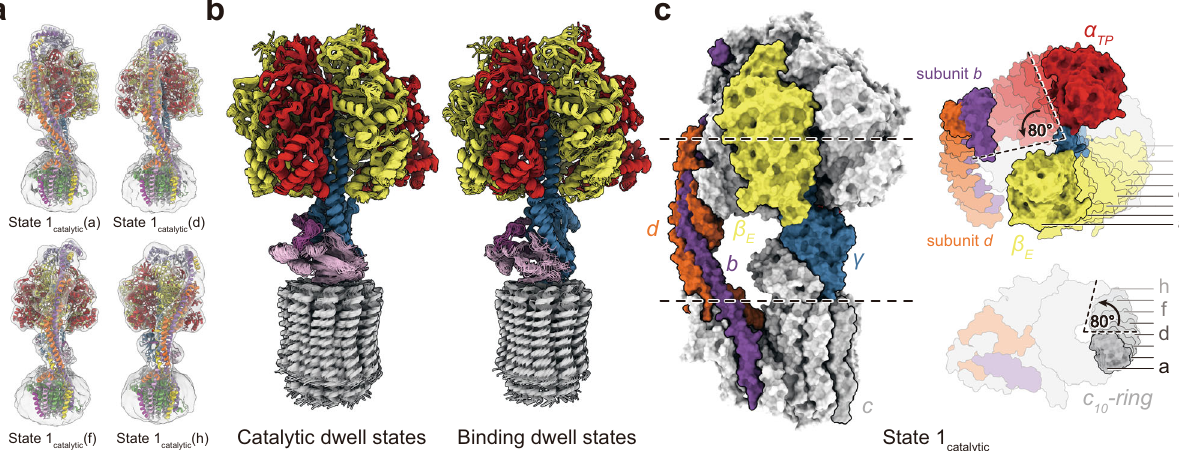
Fig. 2 Atomic models of ATP synthase under strain during ATP hydrolysis. a Atomic models of the enzyme were generated by fl exible fi tting of the atomic models of ATP synthase without ATP into maps of the strained ATP synthase conformations. b Overlay of fi tted models from catalytic dwell (left) and binding dwell (right) structures show limited conformational changes in the α 3 β 3 γδε c 10 subcomplex. c Overlay of models from catalytic dwell conformations show pronounced bending of the peripheral stalk while the enzyme is under strain during ATP hydrolysis.